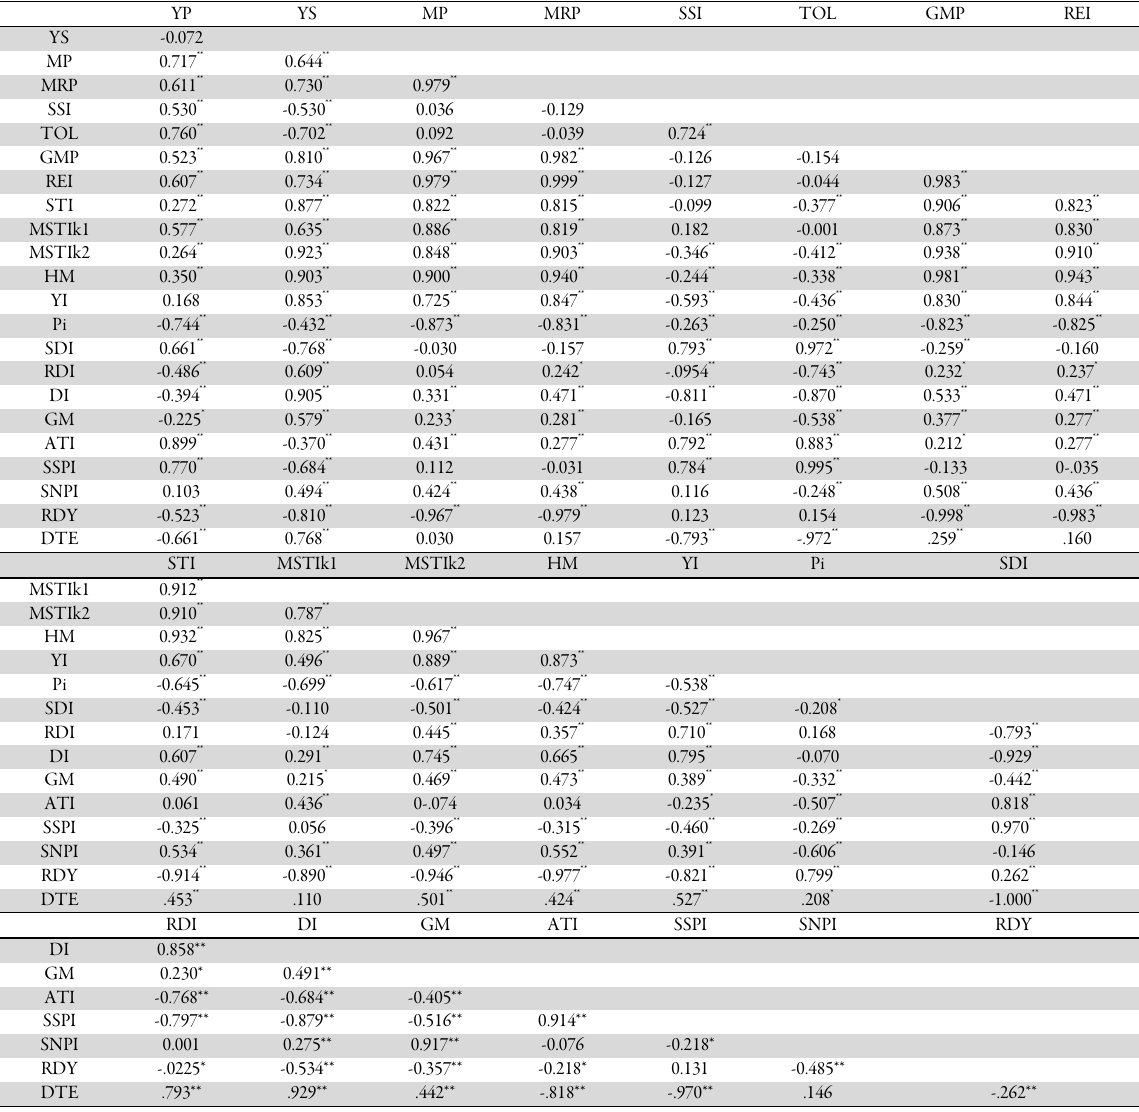
Table 4. Simple correlation coefficients of stress indices with seed yield of 14 chickpea